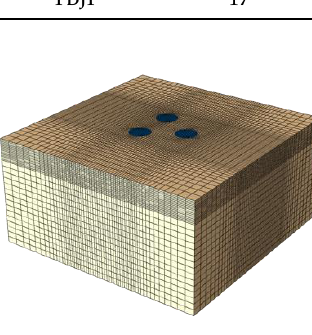
Figure 1. Models of the TSPJF and TBJF. ( a ) TSPJF, ( b ) TBJF, and ( c ) coordinates and bucket num- ber.